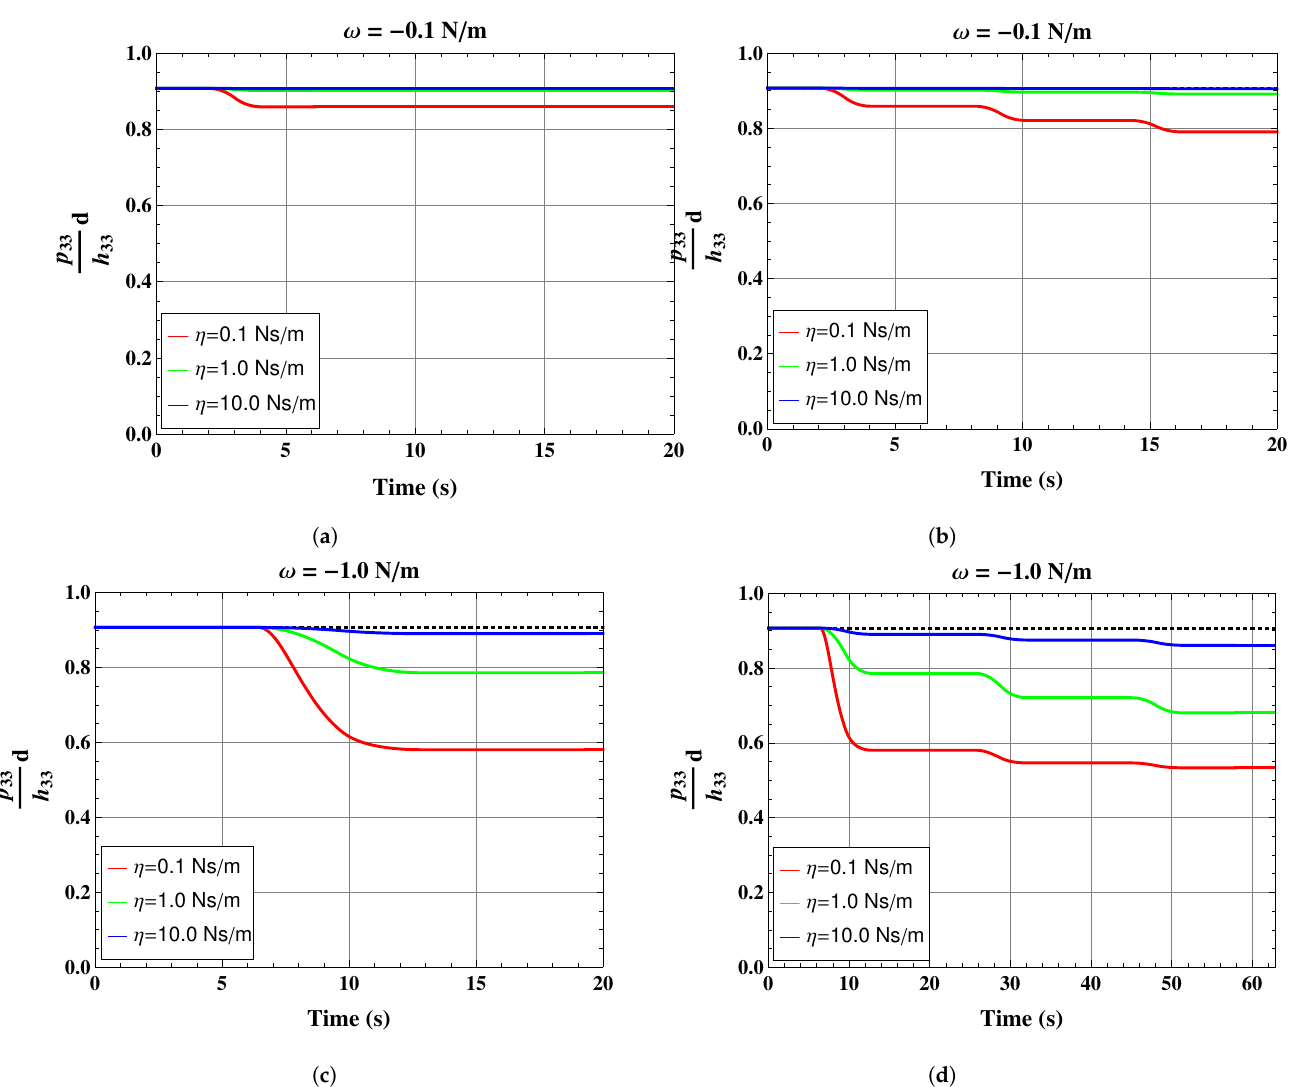
Figure 7. Evolution of the normalized inverse piezoelectric coefficient in a single loading–unloading cycle ( a , c ) and in multiple loading–unloading cycles ( b , d ) of the layered composite depicted in Figure 2. The different plots show the effect of varying ω and η in in the damage evolution Equa- tion (75). For comparison, the normalized inverse piezoelectric coefficient in the purely elastic case is represented with a dotted